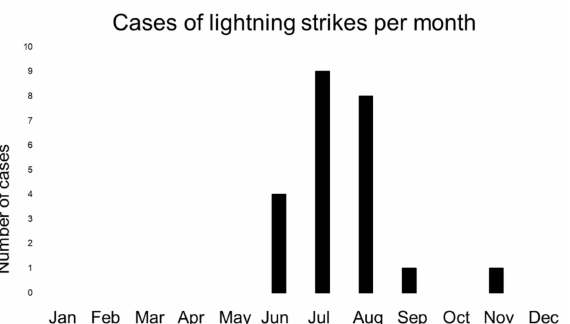
Figure 1. Occurrence of lighting-strike-related emergencies in the Swiss Alps stratified by months for all cases (high-altitude mountaineering and mountain